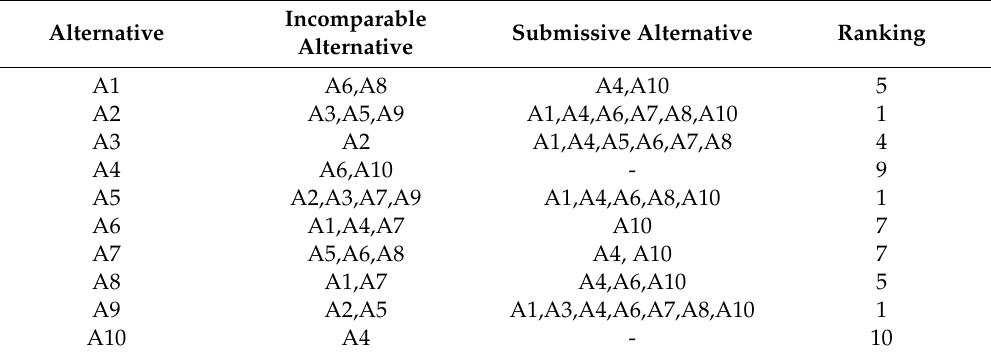
Table 27. The results of fuzzy ELECTRE I